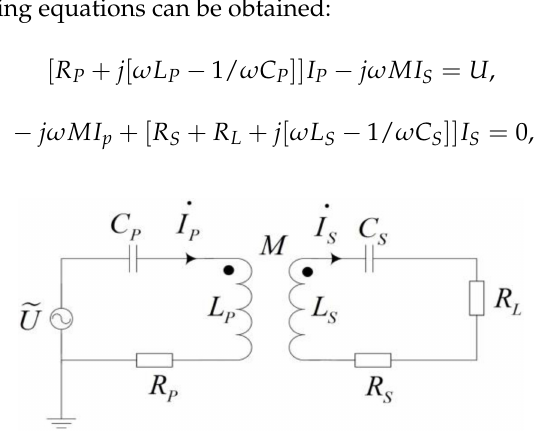
Figure 2. An IPT system model by mutual inductance.